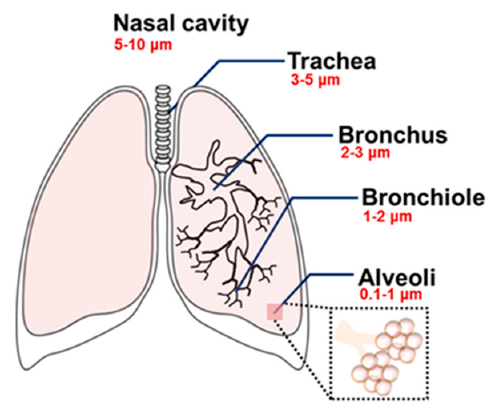
Figure 3. Different airway regions host NPs, showing the size-dependent deposition of NPs. Microsized particles arrest the upper airway regions, while smaller particles reach the deepest lung region (alveoli). Reproduced with permission from reference [114].